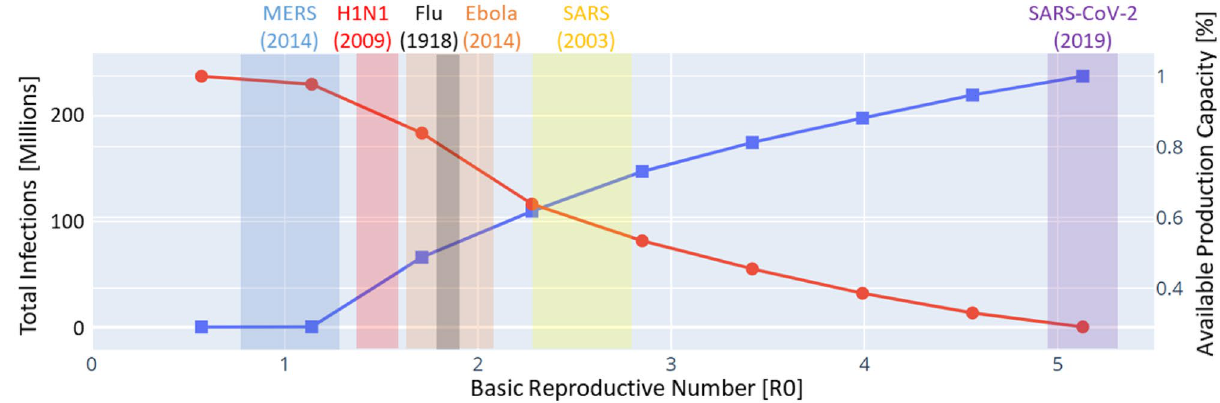
Figure 7. Simulated past infectious diseases in the current world by using the model of coupled networks, which captures time-varying transmission rates changing along with health care resources and